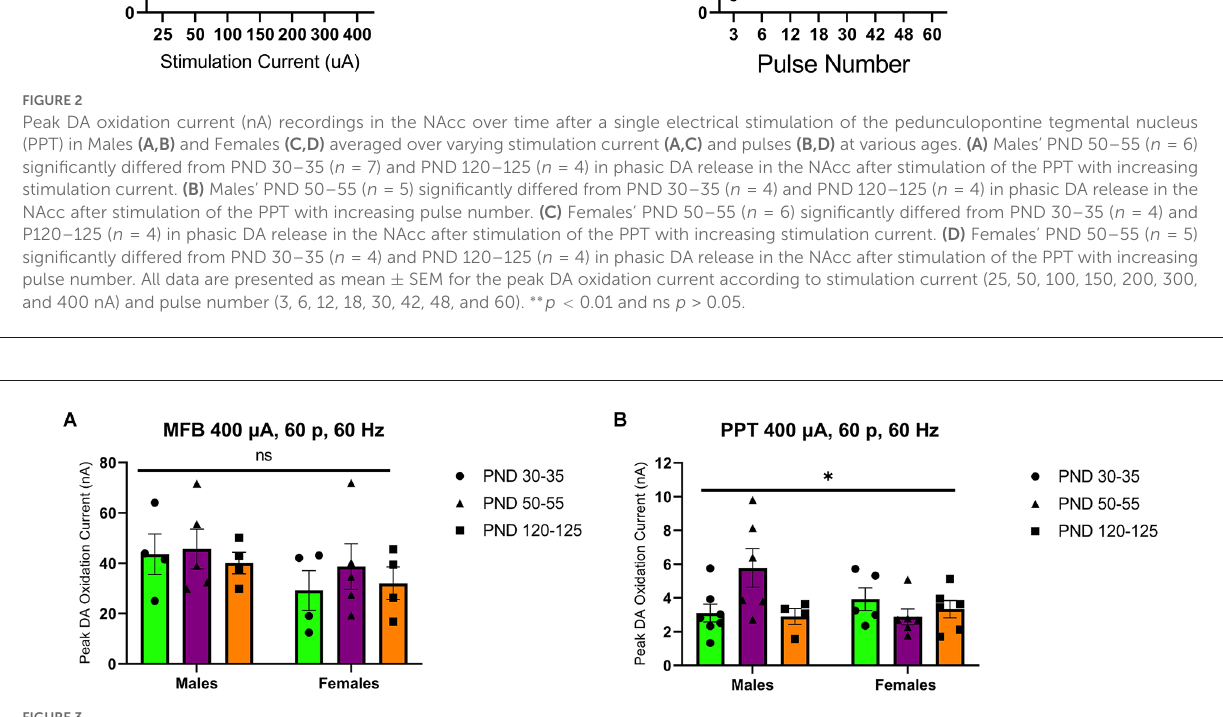
PPT stimulation, there were no significant main effects of sex ( F (1,28) sex = 0.9110, p > 0.05) or age ( F (2,28) age = 1.552, p > 0.05), but there was a significant interaction between these factors ( F ( 2,28 ) sex × age = 4.444, p < 0.05, Figure 3B ). These data